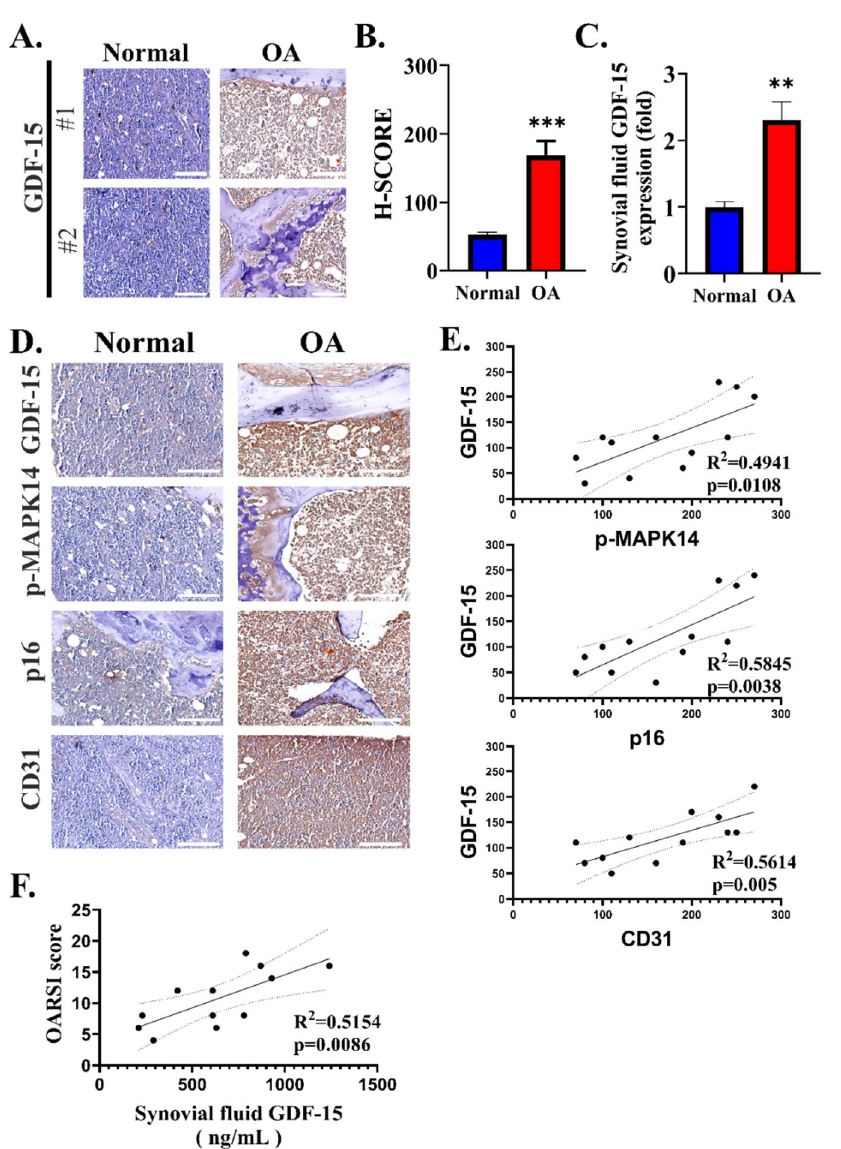
Figure 2. GDF15 is highly expressed in the tissue and synovial fluid of patients with OA. ( A – C ) Comparative study of the expression of GDF15 in healthy individuals and OA patients. ( D – F ) Correlation analysis between GDF15 and MAPK14, p16 as senescence marker, CD31 as angiogenesis marker, and the severity score of OA. ( A ) Representative image of the staining of GDF15 in the synovial membrane. Scale bar: 100 μm ( B ) H score quantification through GDF15 immunohisto- chemistry staining in the synovial membrane of healthy individuals and patients with OA. ( C ) ELISA for GDF15 detection in the synovial fluid of healthy individuals and patients with OA. ( D ) Immunohistochemistry staining comparing GDF15, pMAPK14, p16, and CD31 in the synovial membrane of healthy individuals and patients with OA. Scale bar: 100 μm ( E ) Moderate correlation of GDF15 expression with pMAPK14 (R 2 = 0.494), p16 (R 2 = 0.584), and CD31 (R 2 = 0.561) in the syn- ovial membrane tissues of healthy individuals and patients with OA. ( F ) Moderate correlation of GDF15 expression in the synovial fluid and patients’ OARSI scores (R 2 = 0.494). ** p < 0.01 and *** p < 0.001. The immunohistochemistry results revealed that GDF15 was highly expressed in the synovial membrane (SM) of the patients with OA compared with the SM of healthy indi- viduals (Figure 2B). In addition, ELISA showed that GDF15 was strongly detected in the